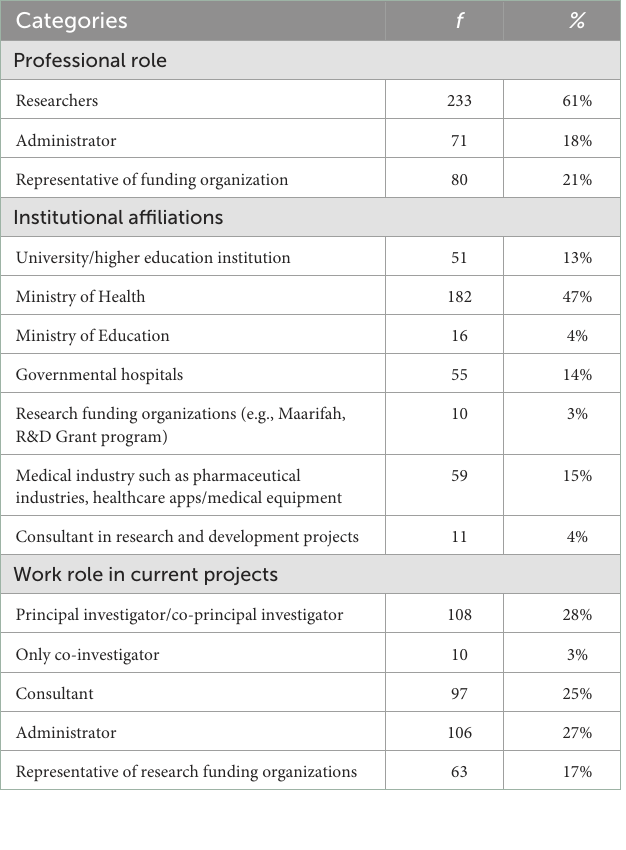
TABLE 4 Health problems investigated in current research projects of